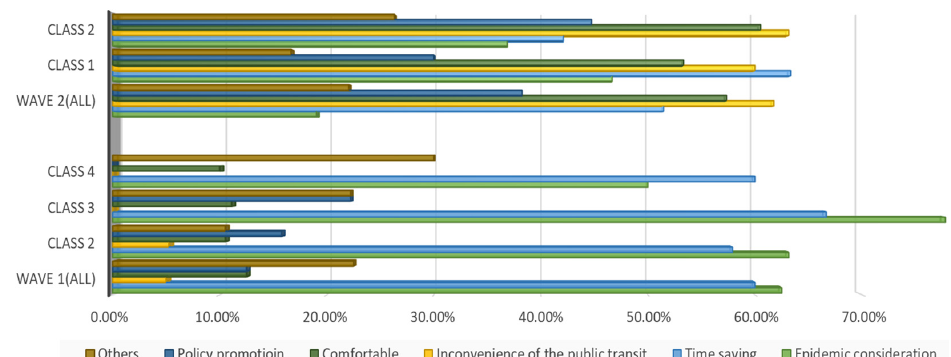
Figure 8. The reasons for purchasing a car.